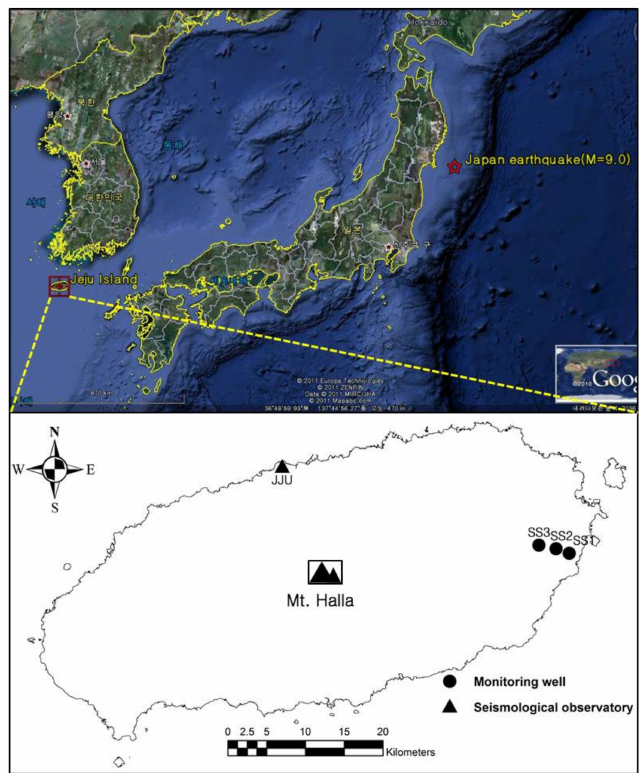
Figure 1. Map showing the monitoring wells and the seismological observatory on Jeju Island and the location of the epicenter of the 2011 M 9.0 Tohoku-Oki